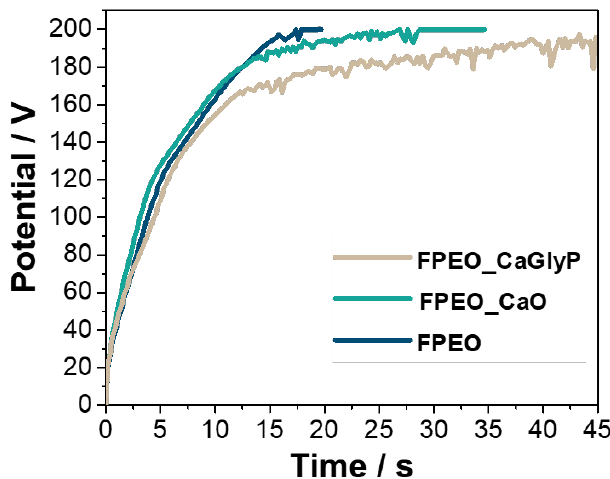
Figure 1. Voltage–time curves registered during the FPEO processes in the basic electrolyte and electrolytes doped with CaO or CaGlyP.